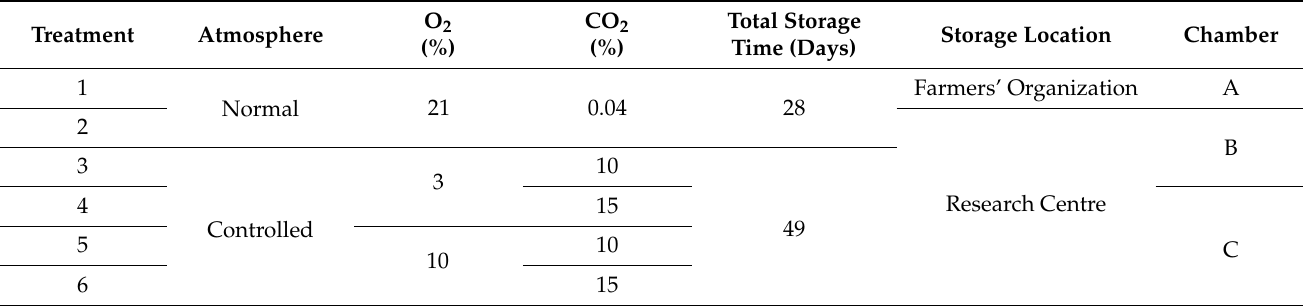
Table 1. Description of the experimental design used in the sweet cherry cv. Satin conservation study: atmosphere conditions, storage time and location of the refrigeration chambers.